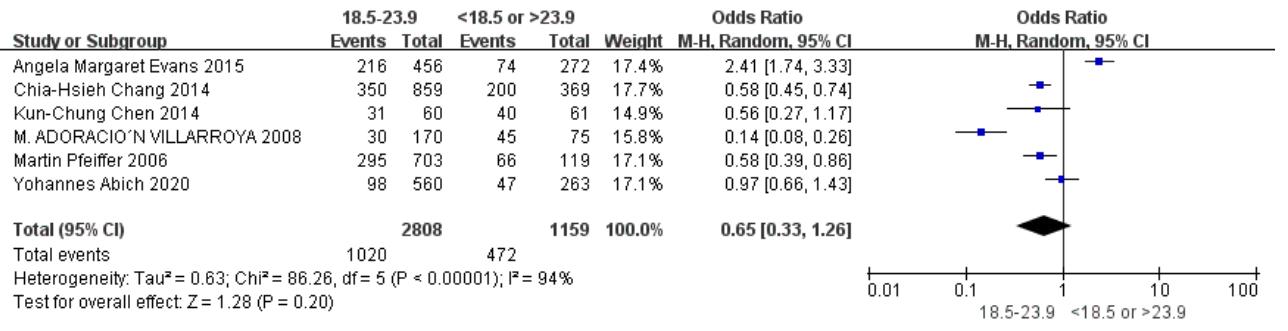
Figure 10. The forest plot of BMI for flatfoot in children [8,9,13,14,17,20].